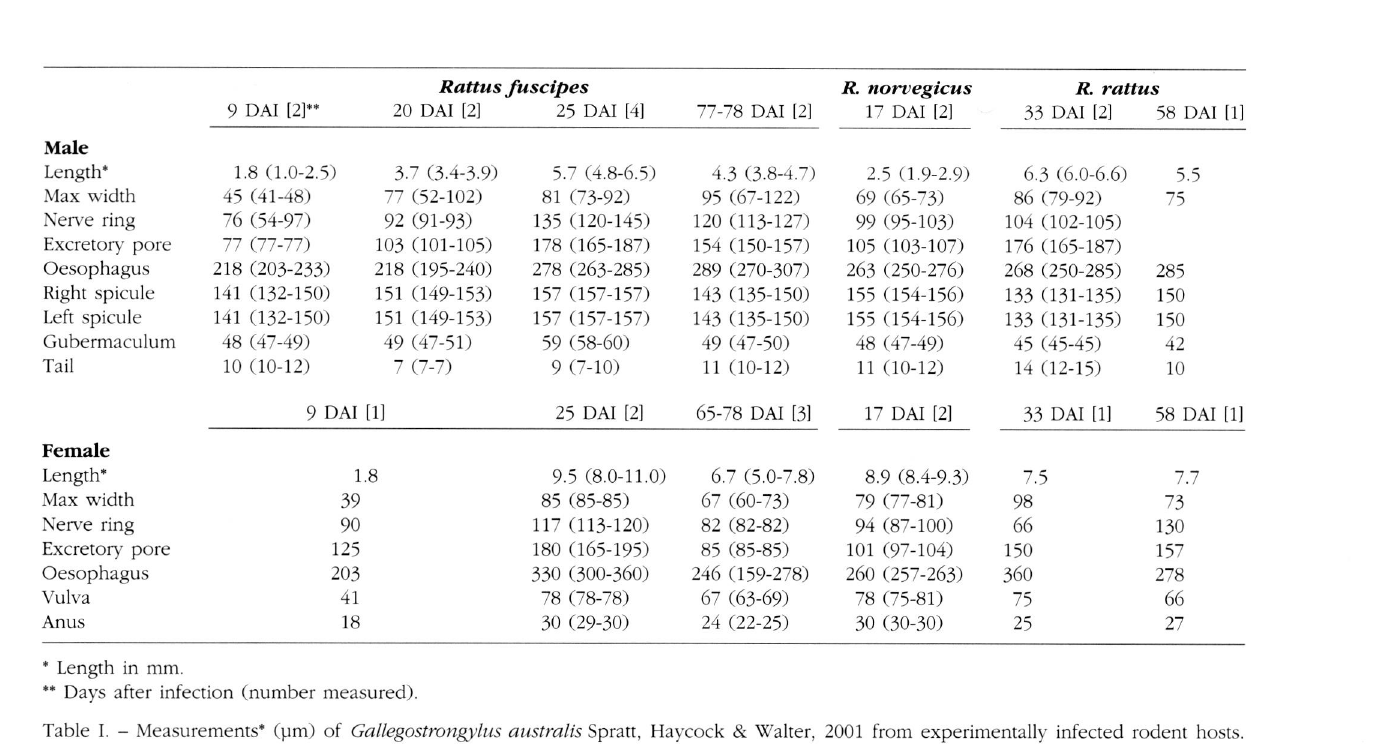
* Length in mm. ** Days after infection (number measured). Table I. - Measurements* Qjm) of Gallegostrongylus australis Spratt, Haycock & Walter, 2001 from experimentally infected rodent hosts.